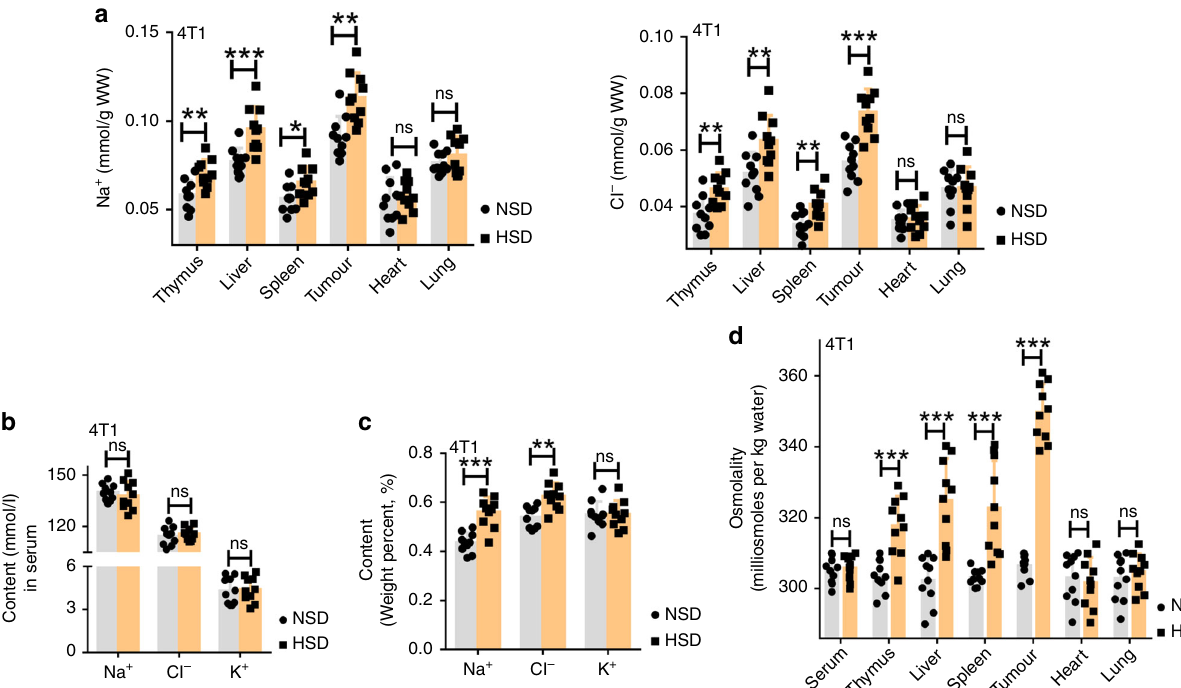
Fig. 2 HSD increased tissue osmotic stress via promoting NaCl accumulation. a , b Na + and Cl − content in different organs compared with plasma concentrations in the same mice when 4T1 tumour-bearing mice were fed the NSD and HSD for 16 days. c Na + , K + and Cl − content in tumour tissues was determined by X-ray fl uorescence spectrometry. d The osmolality of tissues from 4T1 tumour-bearing mice was examined by vapour-pressure osmometry. For all panels, the two-tailed Wilcoxon rank-sum tests; n = 10 mice per group; ns not signi fi cant; * p < 0.05, ** p < 0.01 and *** p < 0.001. These experiments were replicated with a comparable number of mice three times. Data are representative of three independent experiments, and are presented as the mean ± SEM. Source data are provided as a Source Data fi